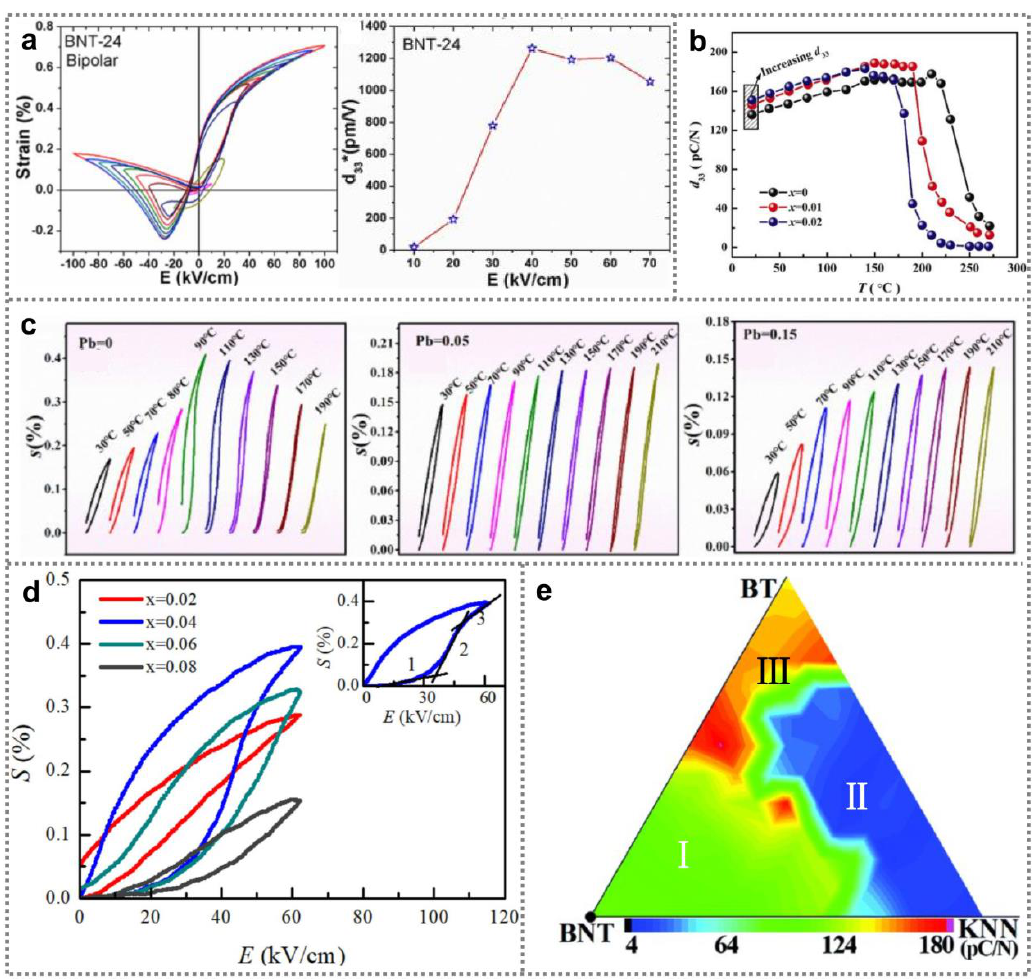
Figure 4. Piezoelectricity of BNT ferroelectric nanomaterials. ( a ) Bipolar S - E patterns of Sr 0.24 (Bi 0.76 Na 0.73 Li 0.03 ) 0.5 TiO 3 ceramics (Reproduced with permission from [65], Elsevier, 2020).